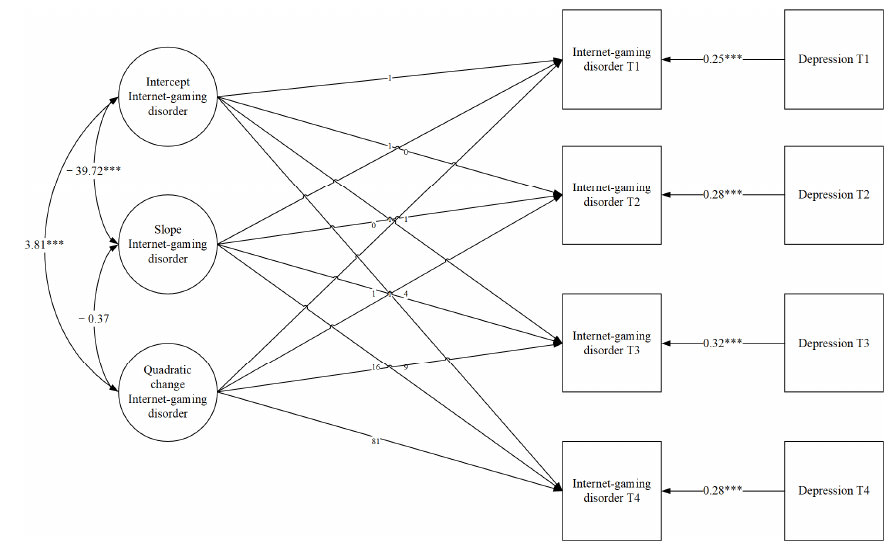
Figure 3. Quadratic LGMs with time-varying covariates. *** p < 0.001.